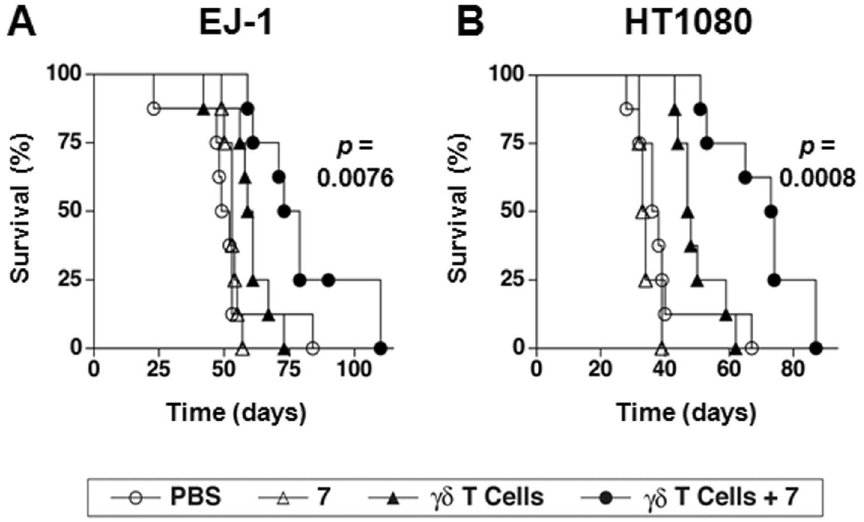
Figure 6. Combination therapy with compound 7 and γδ T cells prolongs survival of immunodeficient NOG mice inoculated with either human EJ-1 bladder carcinoma cells or human HT1080 fibrosarcoma cells. On day 0, NOG mice were inoculated i.p. with 1.0 × 10 6 EJ-1 or 1.0 × 10 6 HT1080 tumor cells that had been stably transfected with the luc2 luciferase. On day 3 and day 6, the mice were treated with either (1) PBS ( ⚪ ), (2) compound 7 ( ∆ ) (2 μ g (97 μ g/kg) for EJ-1 or 10 μ g (485 μ g/kg) for HT1080), (3) 2 × 10 7 γδ T cells ( ▴ ), or (4) 2 × 10 7 γδ T cells and compound 7 ( ⚫ ) (2 μ g (97 μ g/kg) for EJ-1 or 10 μ g (485 μ g/kg) for HT1080). This treatment regimen was repeated for the duration of the experiment. ( A ) Survival of mice inoculated with EJ-1 cancer cells untreated or treated as above. Pooled data from two experiments performed identically is shown, n = 8 mice per group. ( B ) Survival of mice inoculated with HT1080 cancer cells untreated or treated as above. Pooled data from two experiments performed identically is shown, n = 8 mice per group except for mice treated with compound 7 where 4 mice were used. γδ T cells expressing V γ 2 V δ 2 TCRs (95–98% of transferred cells) were expanded from PBMC from a single donor and frozen for later use. Significance is shown for the survival difference between γδ T cells and compound 7 compared with γδ T cells alone as determined by the log-rank